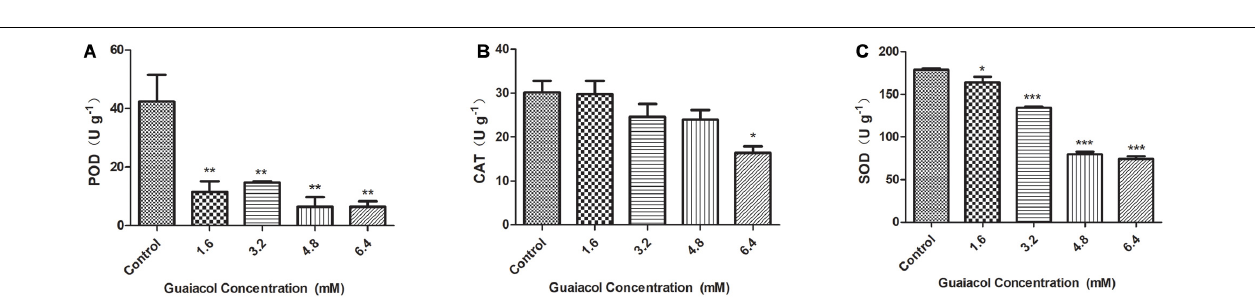
FIGURE 4 | Effects of guaiacol on the antioxidant enzymes activities of POD (A) , CAT (B), and SOD (C) in F. graminearum . Mycelia treated with guaiacol at 0, 1.6, 3.2, 4.8, and 6.4 mM for 24 h were harvested for the measurements. Each treatment has three replicates, * p < 0.05, ** p < 0.01, and *** p < 0.001.